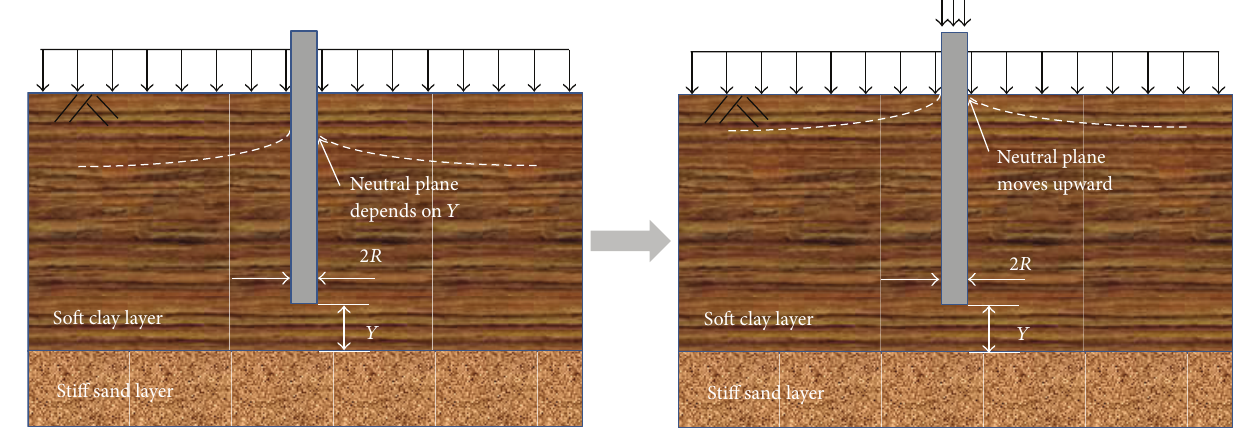
Figure 1: Graphical representations of a pile subjected to surcharge and axial